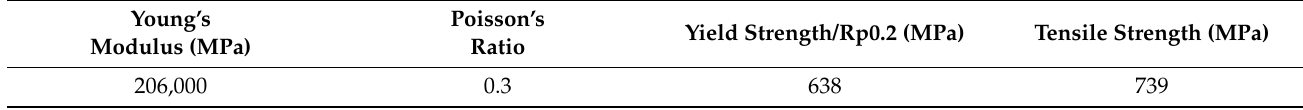
Figure 5. Schematic of weld specimen pick-up.